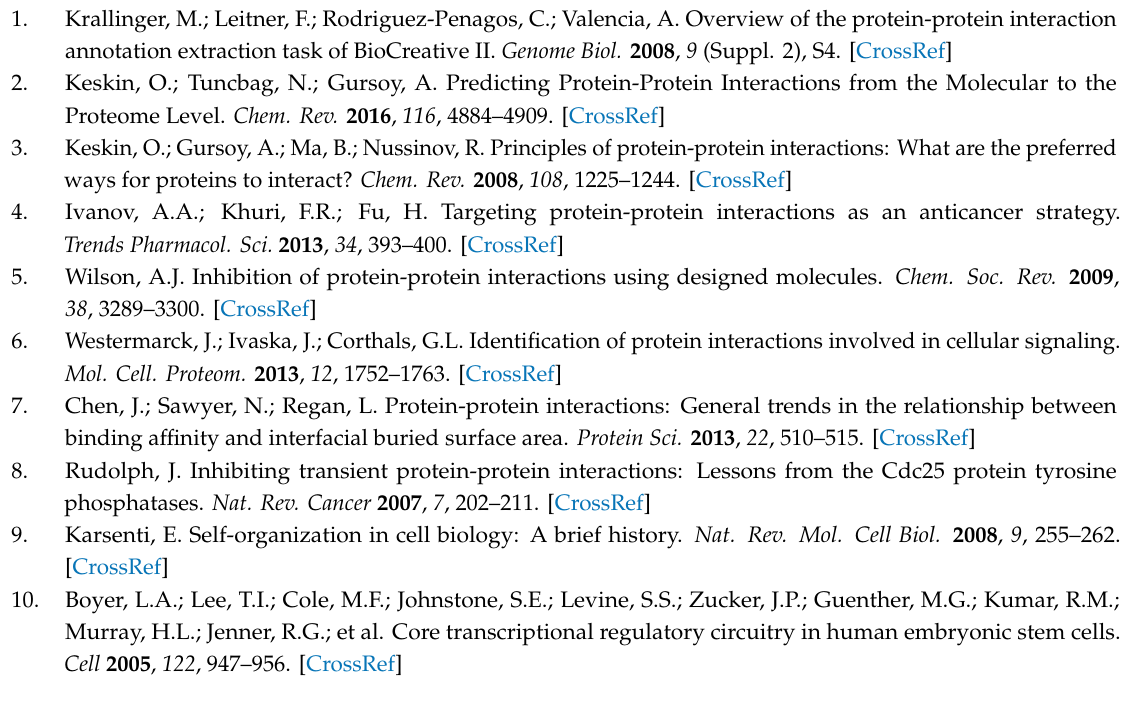
Tables S1–S4: List of bound to Ni-sepharose proteins identified by LC–MS / MS, Table S5: Calculated ratios of Figure S1: Comparison of biotinylation levels in di ff erent fractions (nuclear vs.